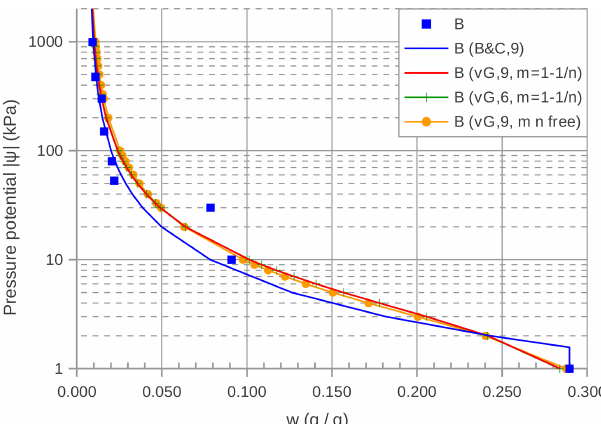
Figure 6. Experimental and interpolated soil-water retention rela- tionships of one of the sandy soils used to repeat Perrault’s exper- iments. B: soil identification; (cid:3) : experimental data; B&C: Brooks and Corey’s curve; vG: van Genuchten’s curve; 6 and 9 are the num- ber of experimental points which were used to interpolate the ana- lytical